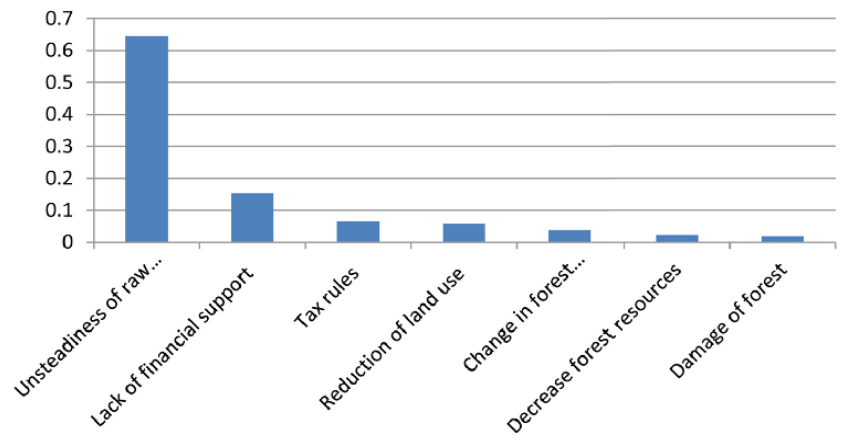
Figure 10: Final synthesis of risks indices (inconsistency rate 0.01), X: Criteria, Y: Weighing